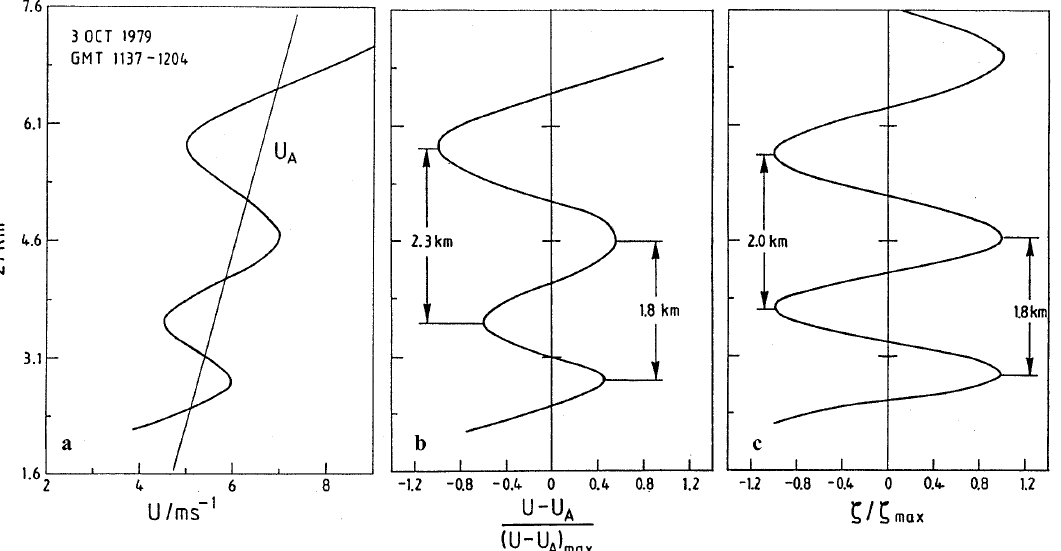
Fig. 3a–c. Height profiles of: a averaged wind speed U deduced from Fig. 2, the straight line shows the linear increase of mean wind speed U with height z ; b relative deviation of wind speed from linear A